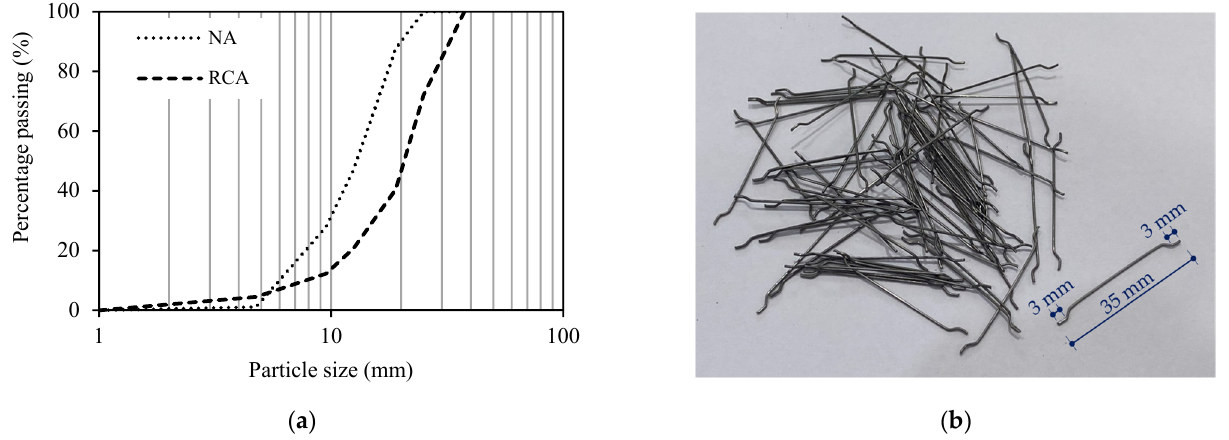
Figure 1. Materials: ( a ) gradation curves of the NAs and RCAs; ( b ) steel fibers.